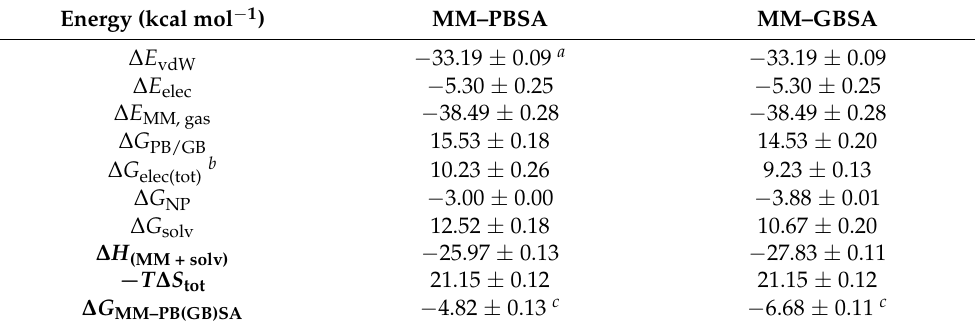
Table 6. MM–PBSA and MM–GBSA free energy calculations for the losartan–2-HP- β -CD complex.